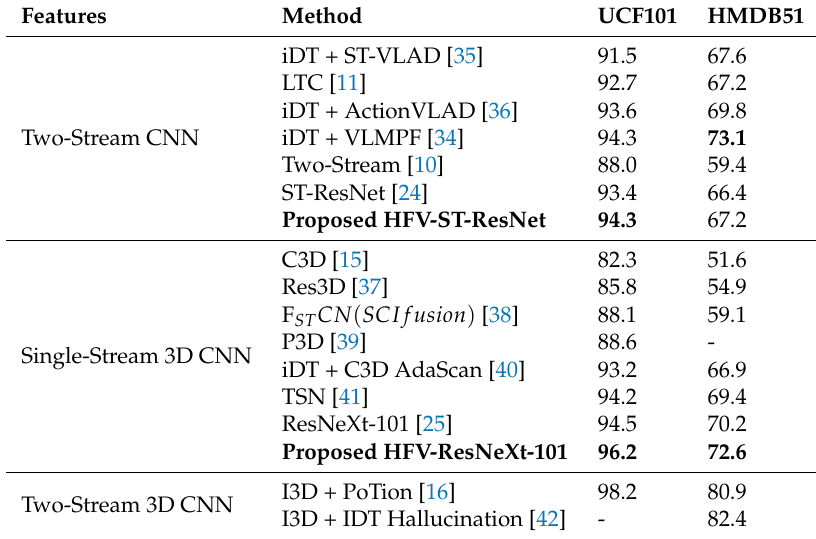
Table 2. Comparison with state-of-the-art